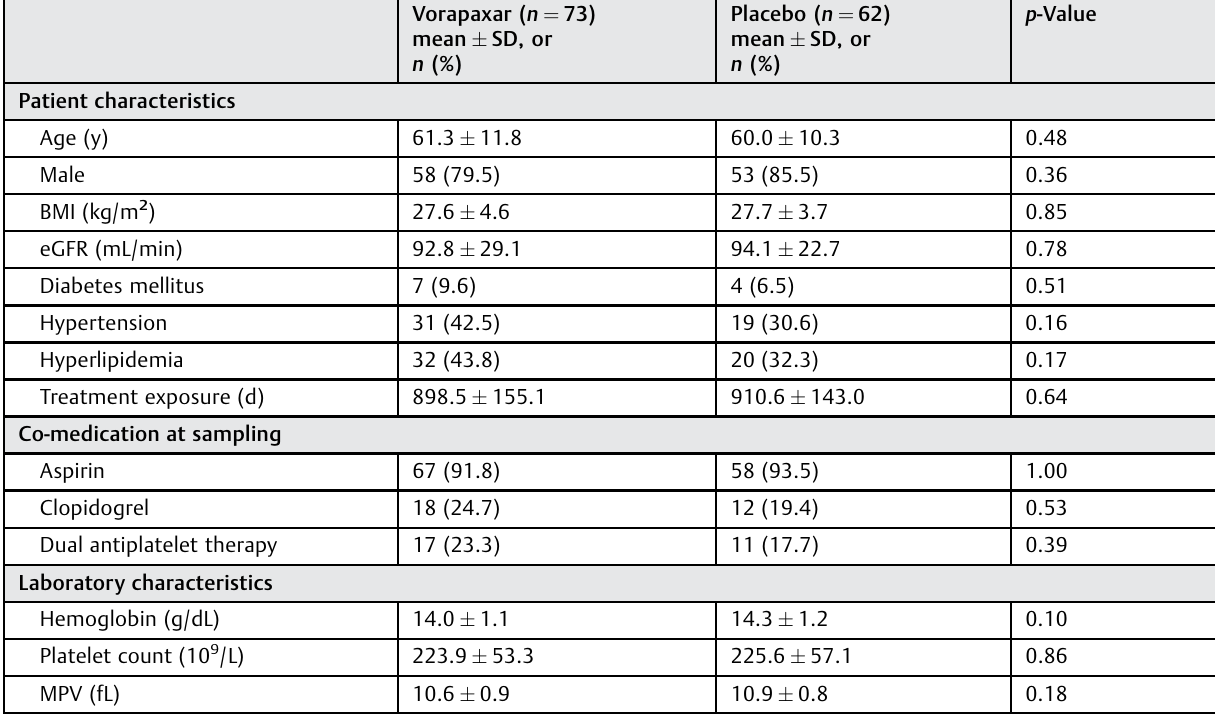
Table 1 Patient